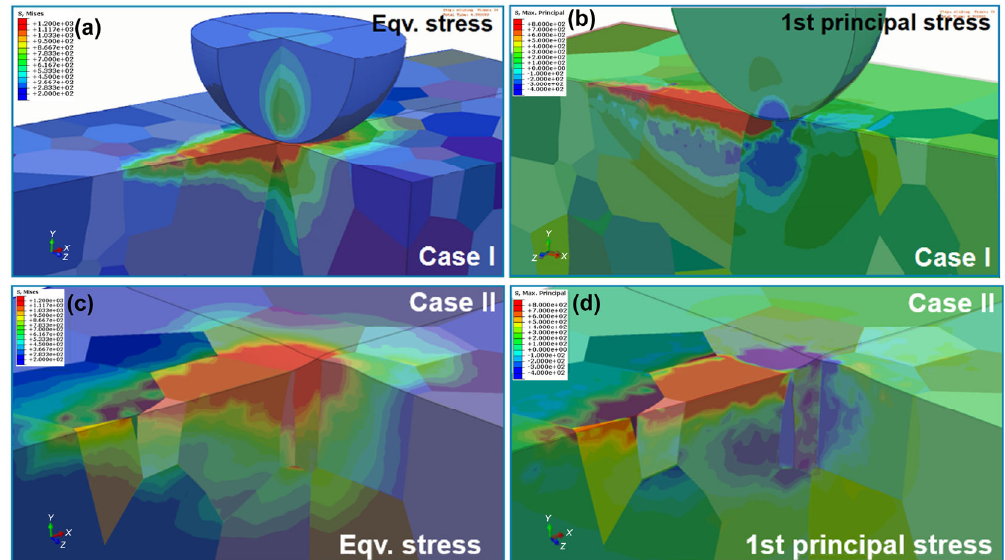
Fig. 2 Equivalent stress: (a) and (c) with the legend contour limited to max 1,200 and min 200 MPa and the 1st principal stress: (c) and (d) with the legend contour limited to max 800 and min –400 MPa during scratching for Case I and